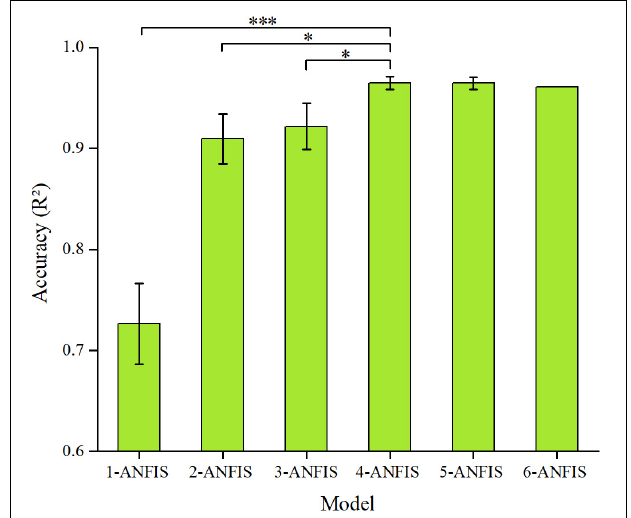
FIGURE 6 | Comparison of the accuracy (R 2 and RMSE) of the ANFIS model using different numbers of passive stretches. The result of the 4-ANFIS model has no significant differences with that of the 5-ANFIS model, but there is a significant difference with those of other models ( ∗ 0.01 < p ≤ 0.05; ∗∗∗ p ≤